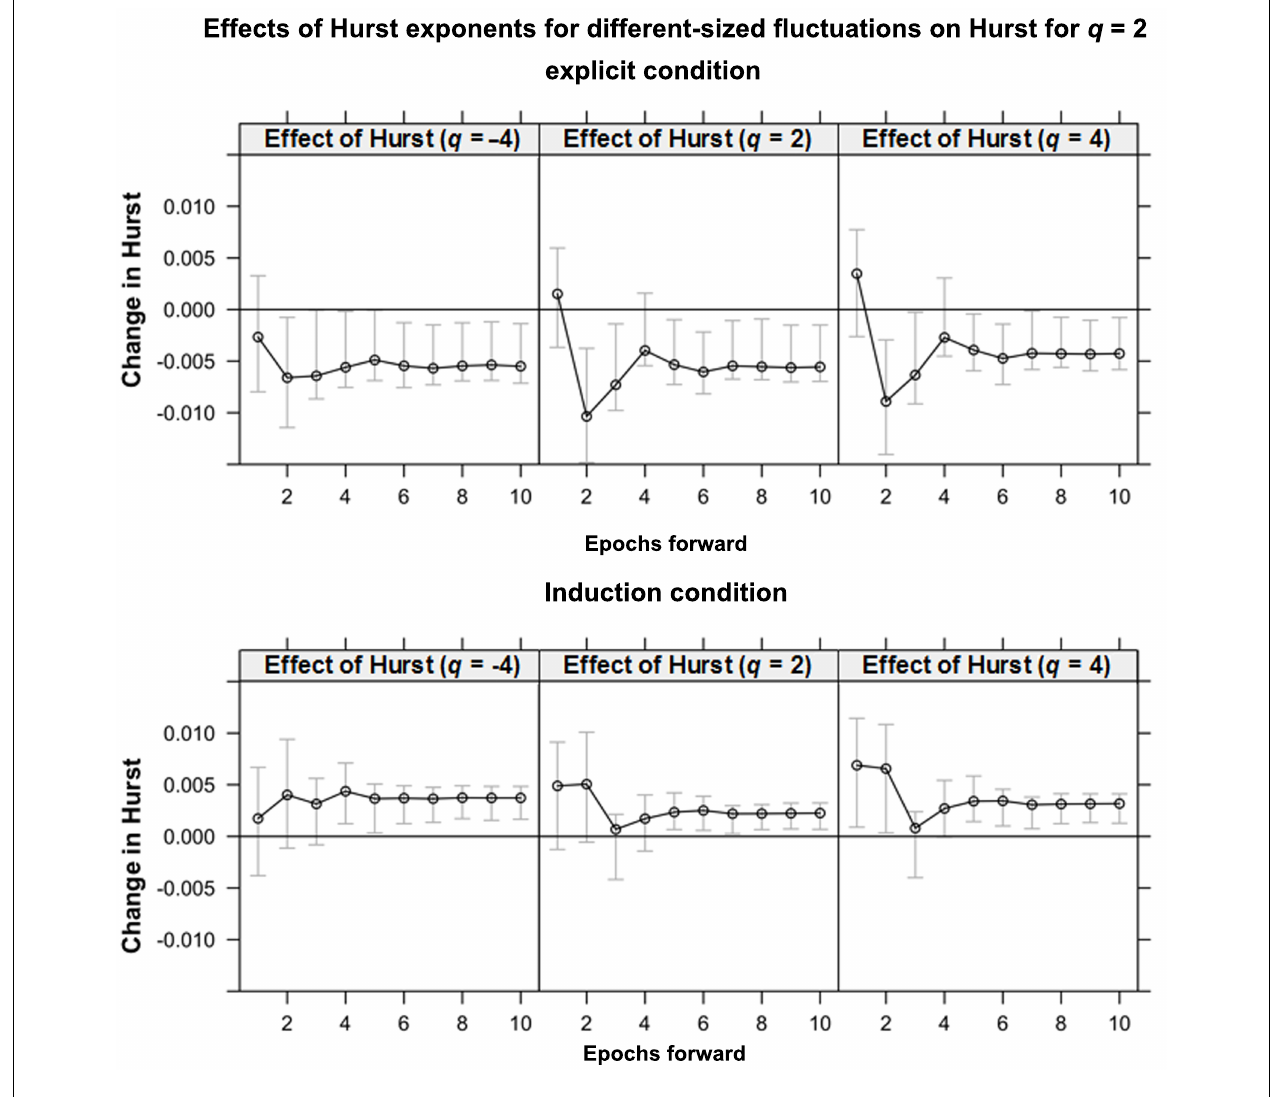
FIGURE 2 |The effect of local Hurst exponent H for three different size-weightings of fluctuations ( q s = − 4, 2, and 4) on later H for fluctuations weighted homogeneously (i.e., q = 2). The y -axis represents the change in the Hurst exponent caused by the perturbation; the x -axis